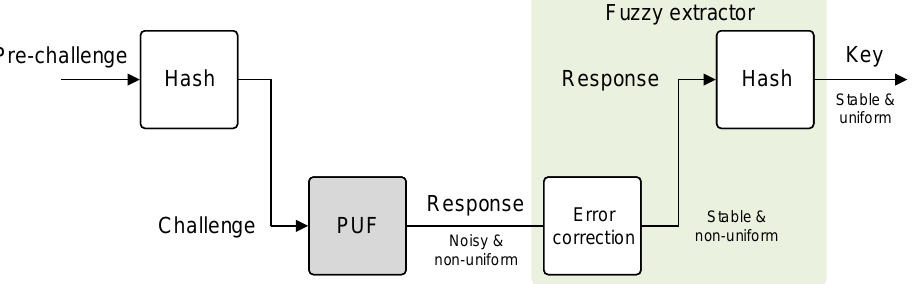
Figure 11. Exemplary controlled PUF environment to obfuscate the PUF interfaces. An integrated fuzzy extractor ensures stable and uniform PUF